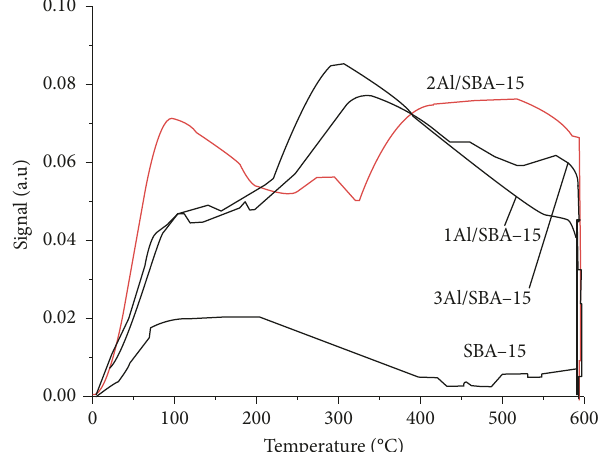
Figure 5: NH 3 -TPD pattern of SBA-15 and xAl/SBA-15